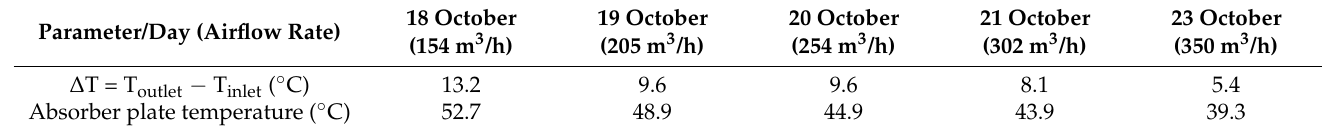
Table 5. GTC configuration: 50 mm-distance absorber—glazing. GTC thermal parameters—mean values (time interval: 13:10–14:10) 2